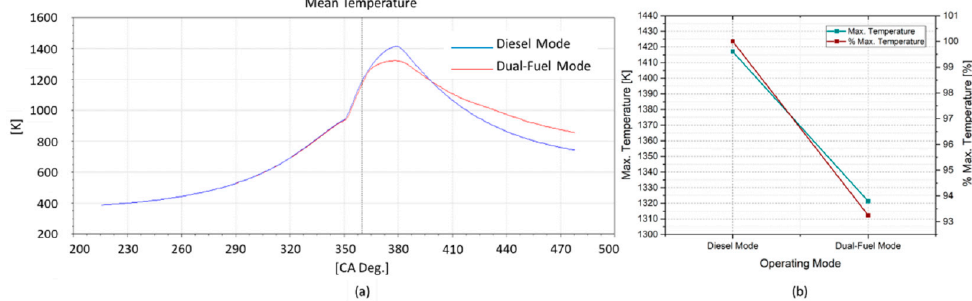
Figure 12. The mean in-cylinder temperature ( a ) and maximum in-cylinder temperature ( b ).